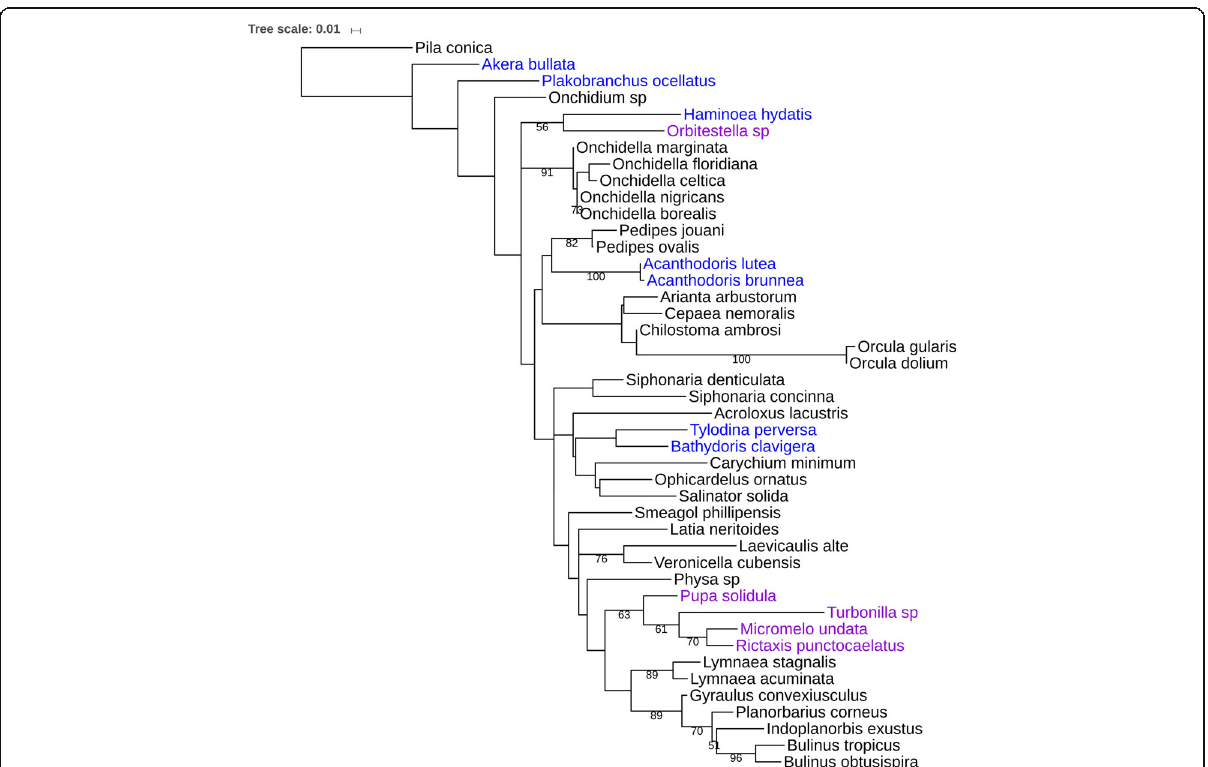
Fig. 2 Maximum likelihood phylogram depicting the relationships among taxa on the basis of H3 (codons 1, 2 & 3 combined) gene. Indicated on the nodes are the bootstrap values. Tree scale of 0.01 represents 1 substitution per 100 nucleotides. Only bootstrap values > 50 are